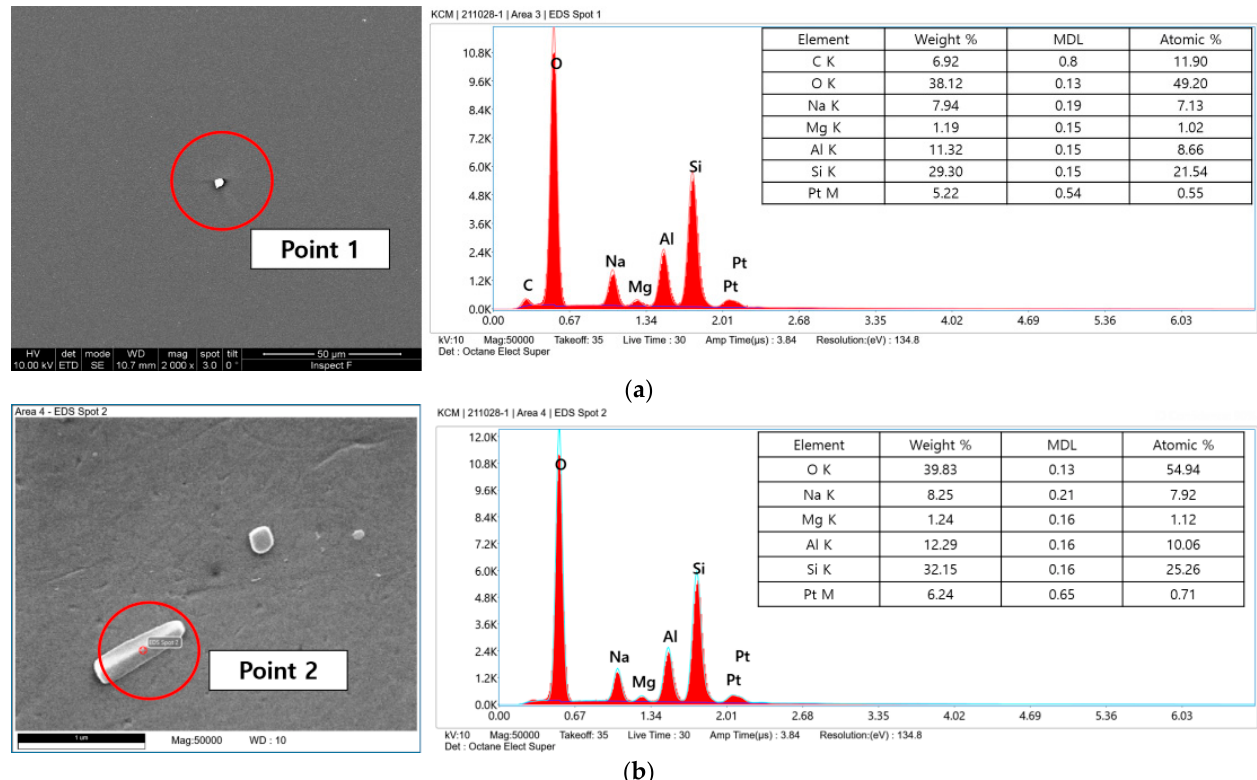
Figure 8. Particle EDS analysis of two points subjected to laser irradiation: ( a ) above focal position and ( b ) assumed broken particles.